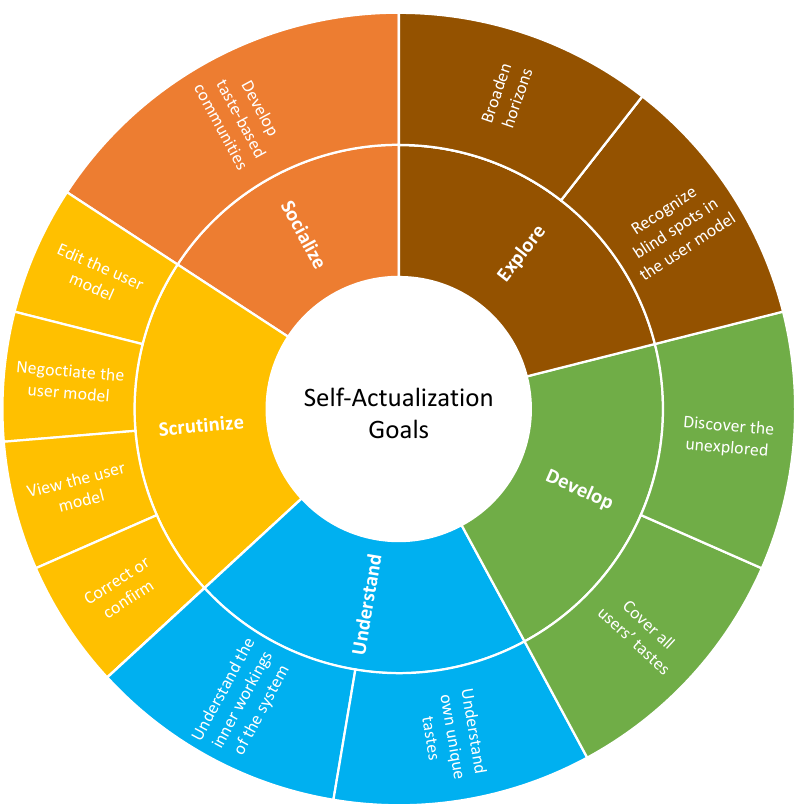
Figure 1. The EDUSS Framework for self-actualization goals of transparent user modeling.